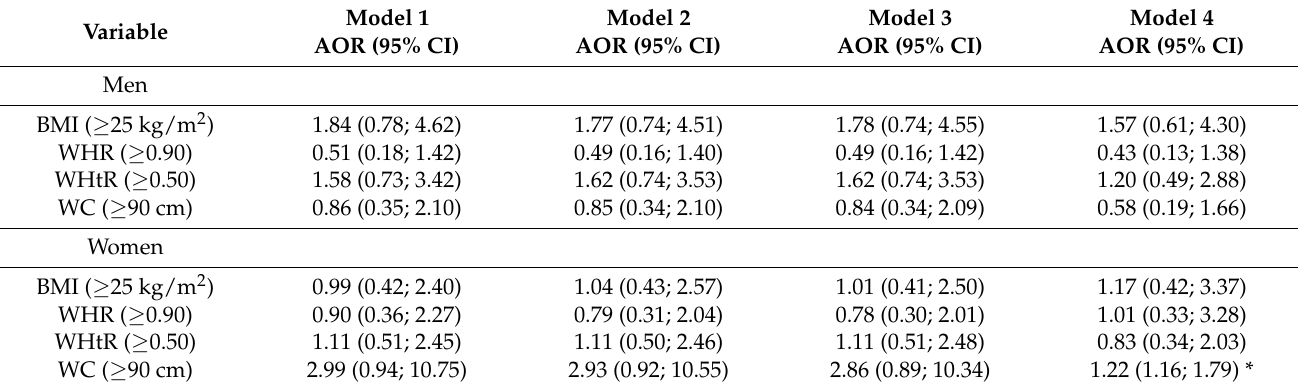
Table 5. Association of obesity indicators with